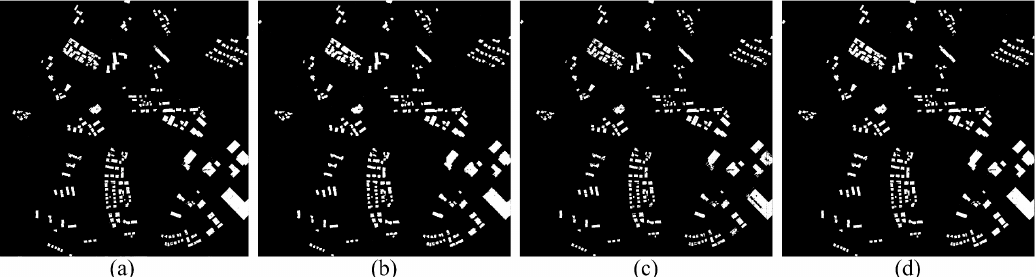
Figure 11. Binary change maps (Experiment 3) obtained by the ( a ) U-Net, ( b ) SegNet, ( c ) DeepLabv3+, and ( d ) Proposed method. Table 5. Details of experiment 4.